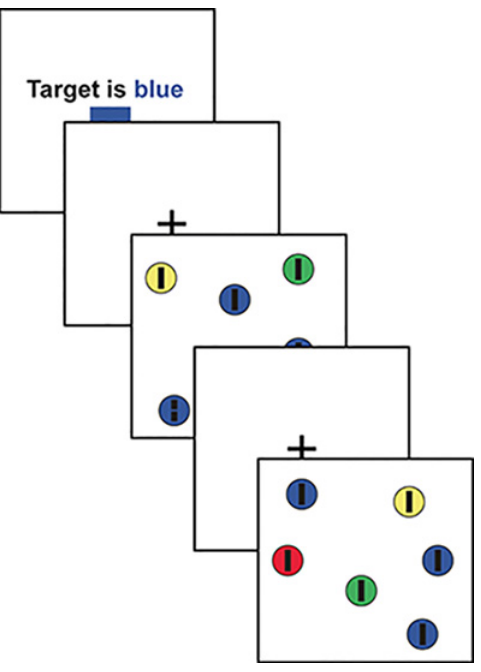
Fig 2. Sequence of search arrays. At the start of each block, the cue is shown. Then, a fixation cross is displayed for 3s, followed by a search array. After 10 search arrays, the block is complete, and a new block